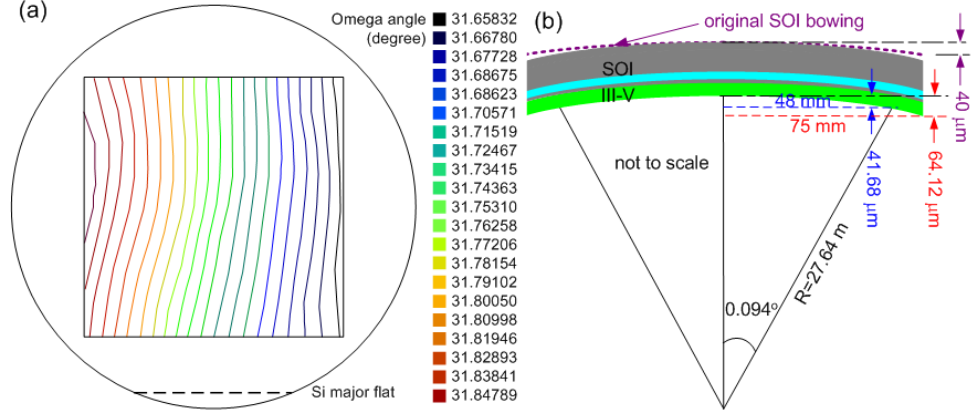
Figure 5. (a) Wafer warpage contour composed of 81 Omega scans at a 9 × 9 matrix with 12 mm step size. (b) Schematic warpage of bonded wafer pair with a bowing of 64.12 μ m with a corresponding surface radius of 27.64 m based on the largest omega angle difference measured in